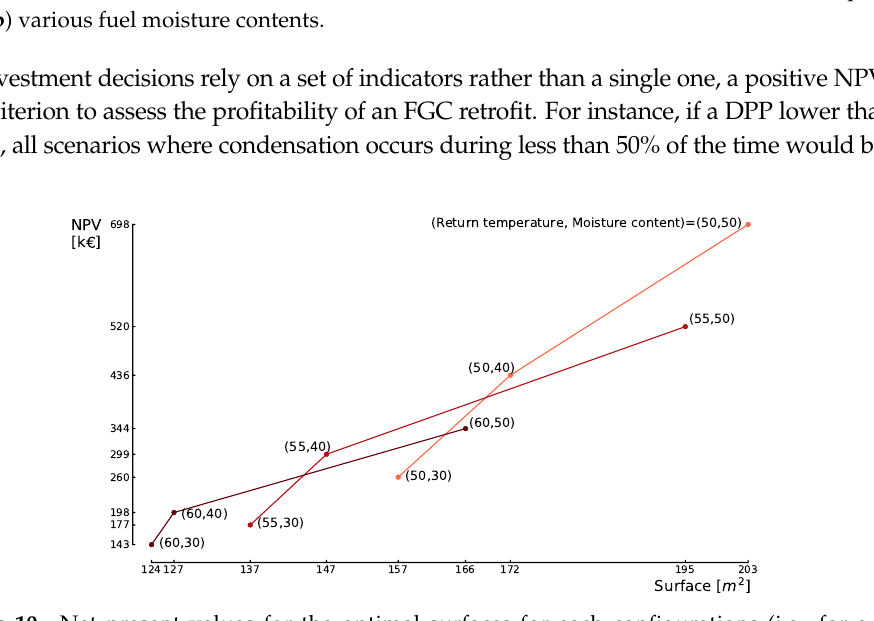
Figure 10. Net present values for the optimal surfaces for each configurations (i.e., for a return temperature and moisture content). Table 5. Net present values, discounted payback periods, modified internal rates of return, and saved energy for the different boundary conditions investigates in this study. Scenario where condensation occurs during less than 50% of the time are highlighted in